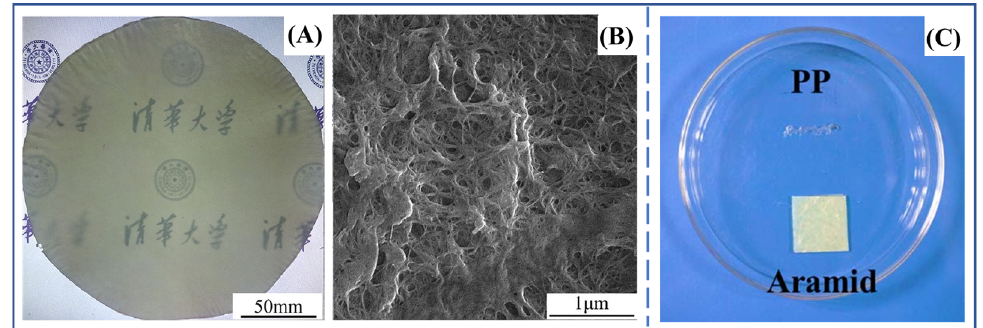
Figure 8. ( A ) Photograph of PANF paper. The Chinese words in subfigure is “Tsinghua University” [59]. ( B ) SEM image of PANF paper [59]. Copyright 2017 Elsevier B.V. ( C ) Photograph of PP